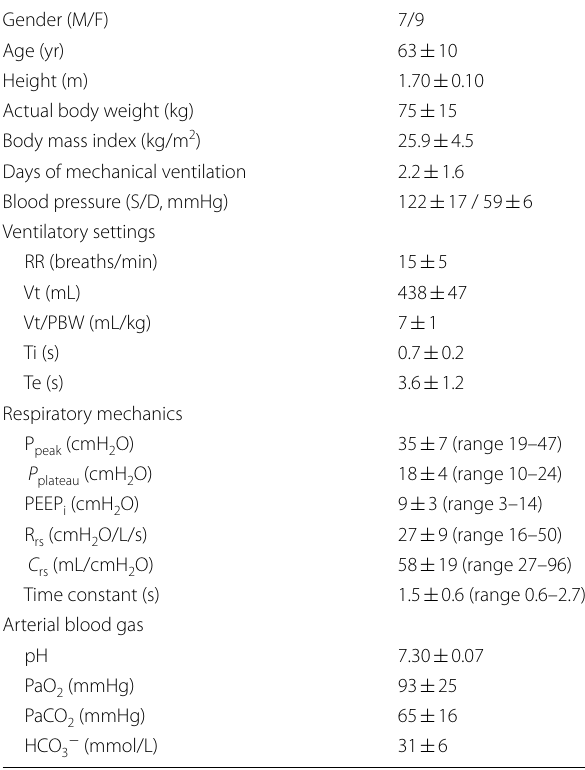
Table 1 Baseline